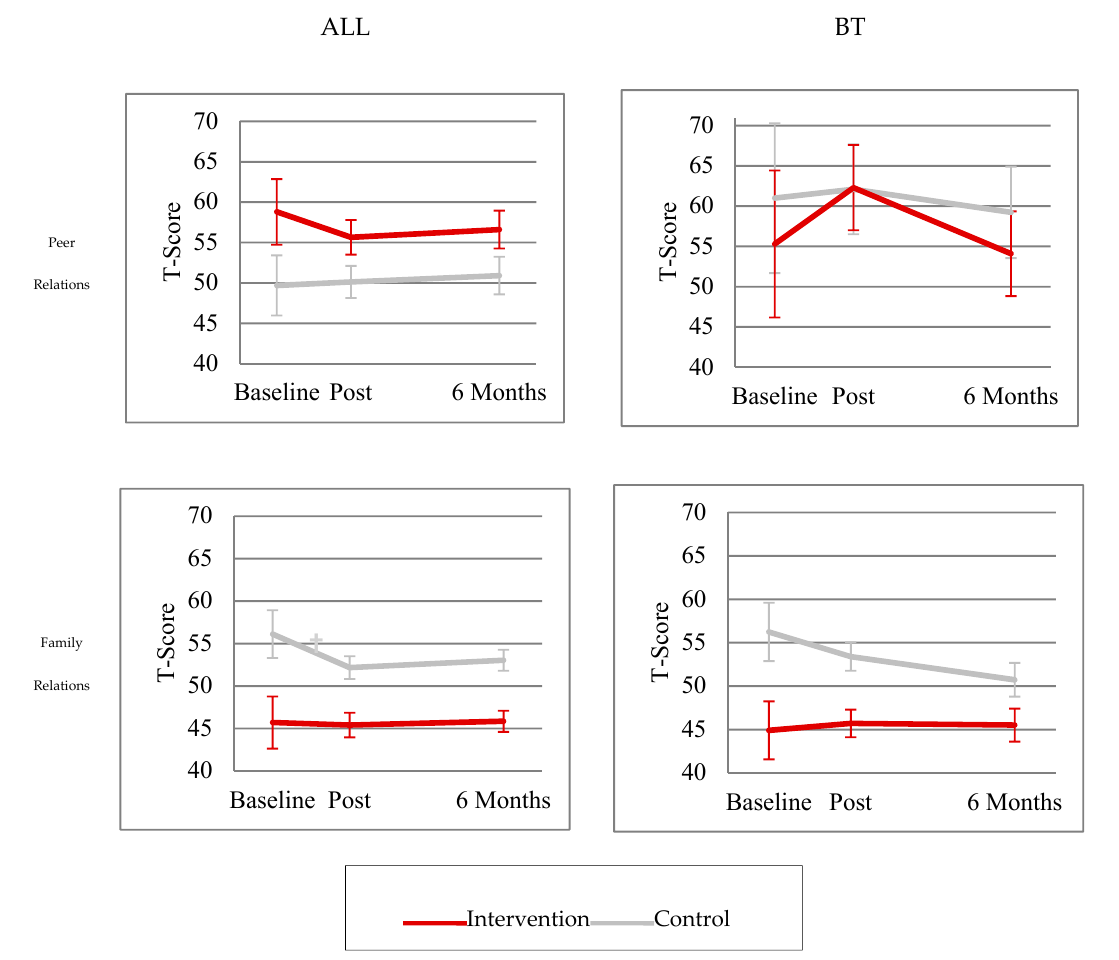
Figure 1. Change in Conners 3 social functioning outcomes over time in ALL vs. BT patients. ALL = acute lymphoblastic leukemia. BT = brain tumor. † Slope vs. 0.